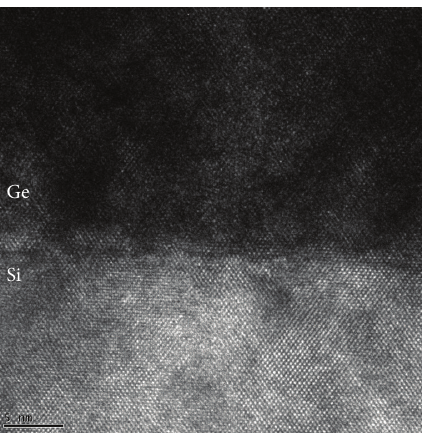
Figure 8: High resolution cross sectional TEM image of the Ge/Si interface.